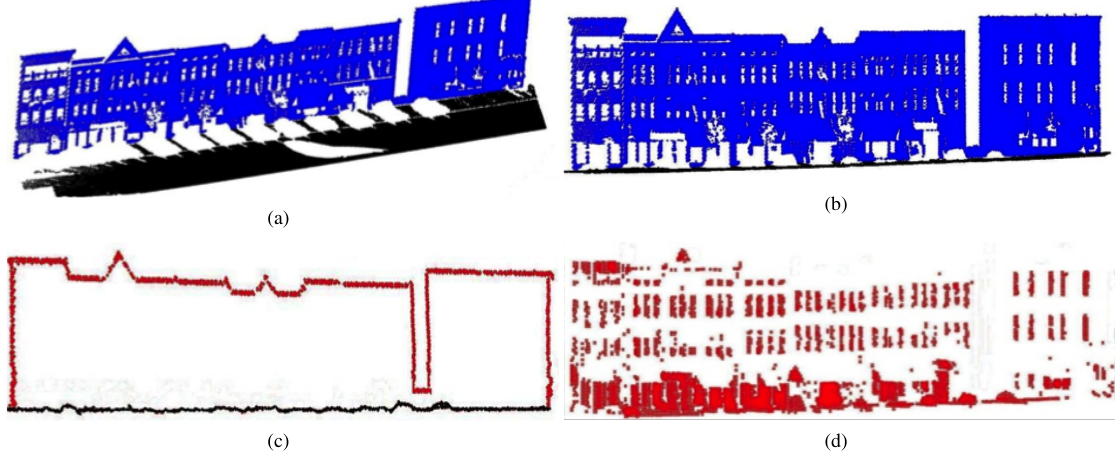
Figure 2: (a) 3D points belonging to building (in blue) and road surfaces (in black). (b) 2D projection of the 3D points on an arbitrary plane. (c) Watertight boundary. In red building outline closed by road projection (black) from below. (d) After point inversion within the watertight